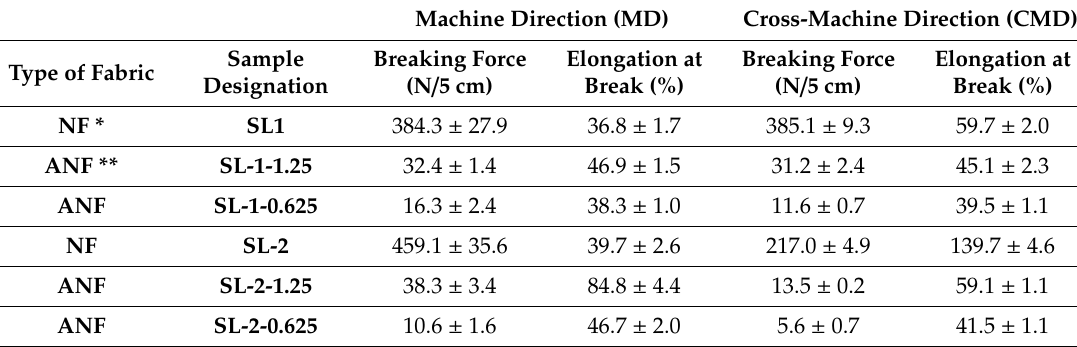
Figure 3. Tensile behavior of the original non-woven Silon (SL) fabric. (MD—machine direction; CMD—cross-machine direction). Table 3. Measurement results of tensile strength and elongation at